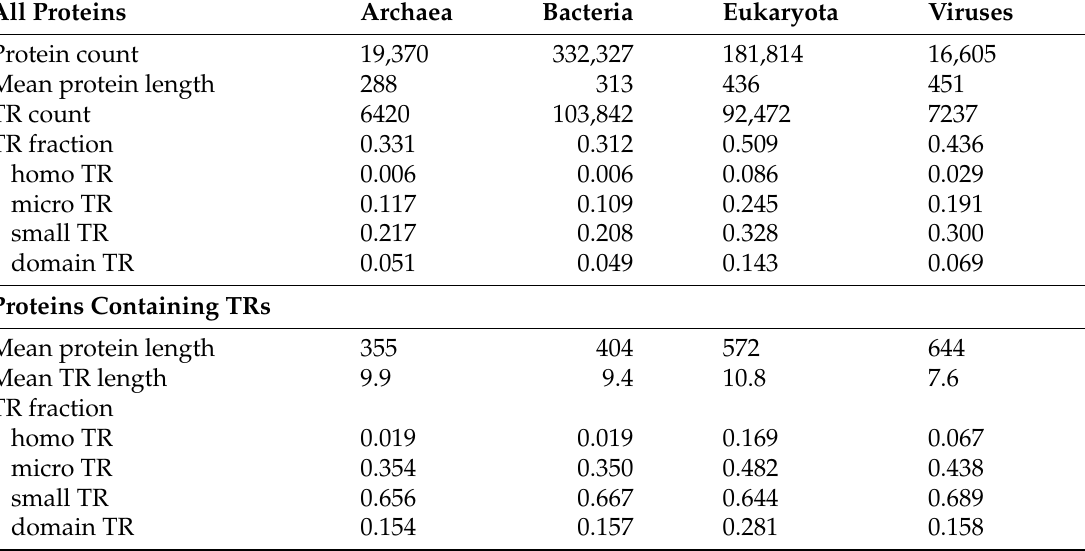
Table 1. Numbers of UniProtKB/Swiss-Prot entries by superkingdoms for all proteins and for proteins that contain TR. The total amount of proteins per superkingdom is given as ‘Protein count’. ‘TR count’ refers to the number of proteins which contain at least one